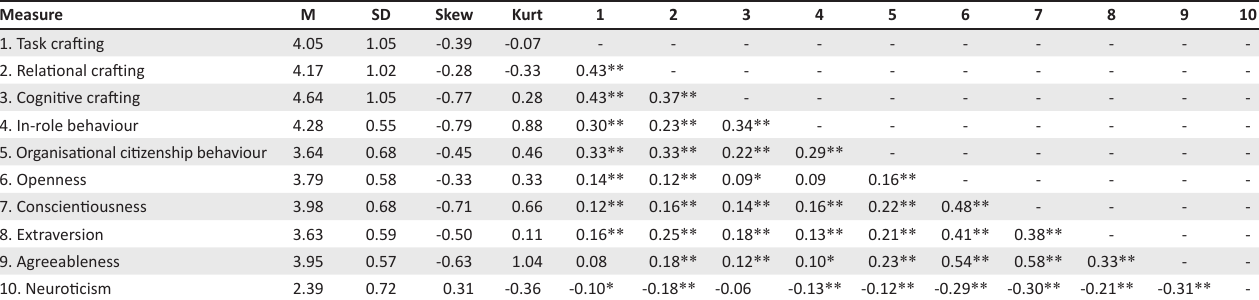
TABLE 1: Descriptive statistics, means, standard deviations and correlations ( N = 580).